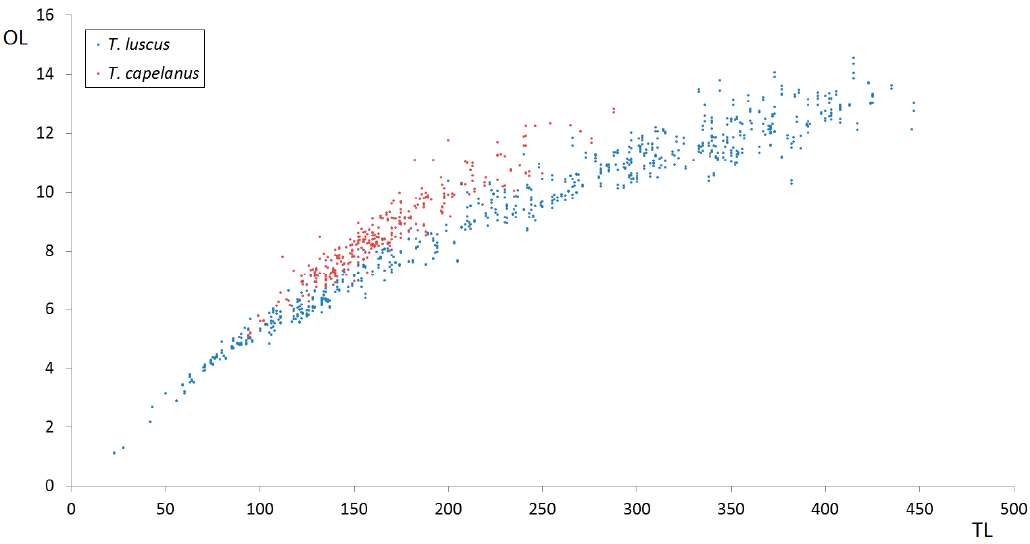
Figure 6. The ratios of otolith length (OL) and total fish length (TL) compared between